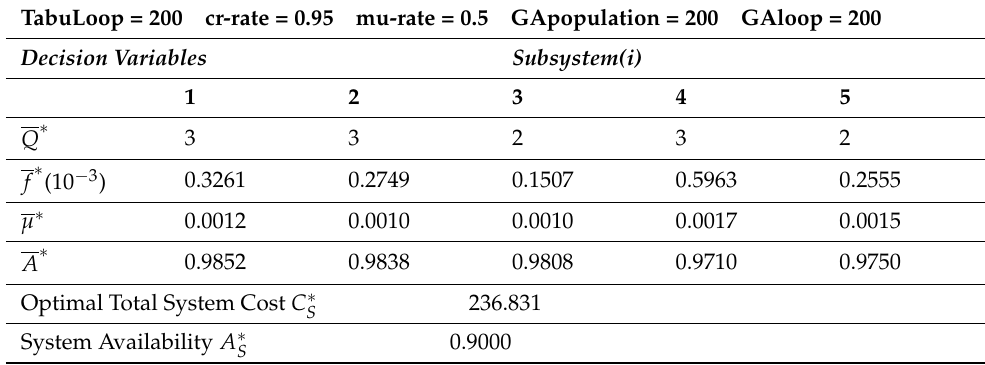
Table 9. The total system costs of 20 simulation runs obtained by SA–GA for the n -stage standby system.